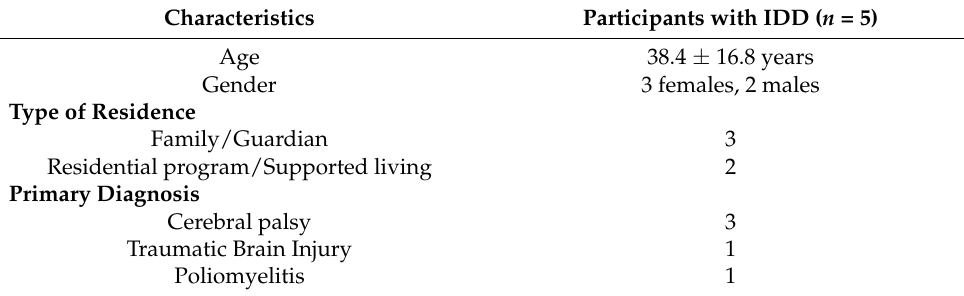
Table 2. Demographic characteristics of staff.